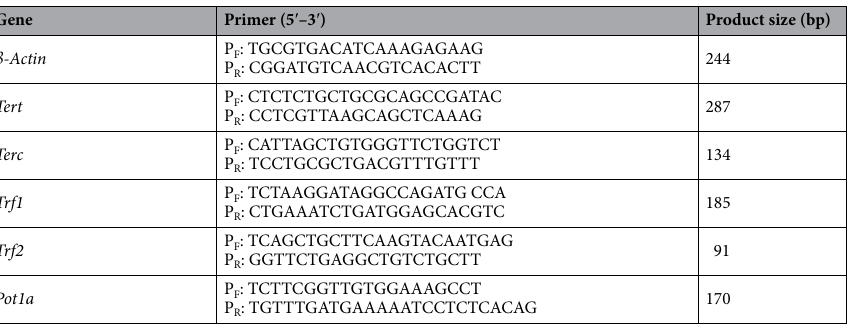
Table 1. The primer sequences and product sizes of the genes. β-Actin beta actin, Tert telomerase reverse transcriptase, Terc telomerase RNA component, Trf1 telomeric repeat binding factor 1, Trf2 telomeric repeat binding factor 2, Pot1a protection of telomeres 1a genes used in this study, P F forward primer, P R reverse primer, bp base